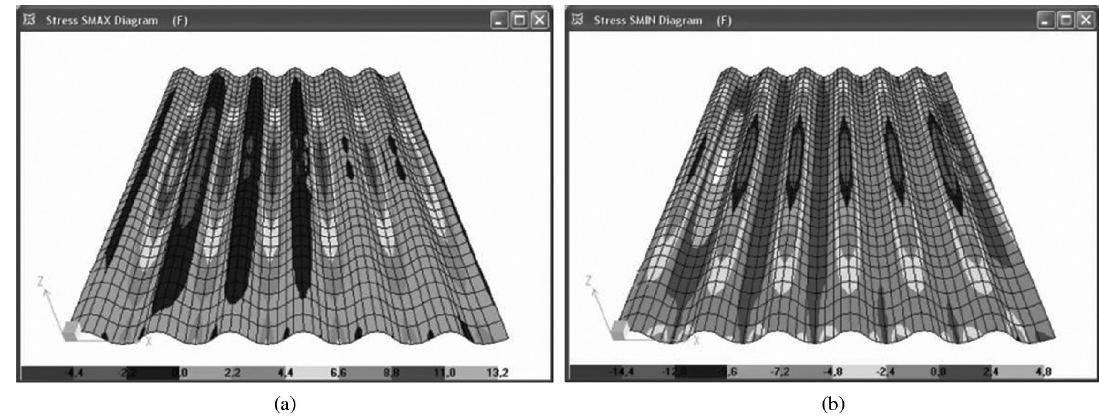
Figure 13. Stresses in the model with span of 1100 mm: (a) Maximum value of tension ( σ Maximum value of compression ( σ ) in the upper surface of the high wave. min